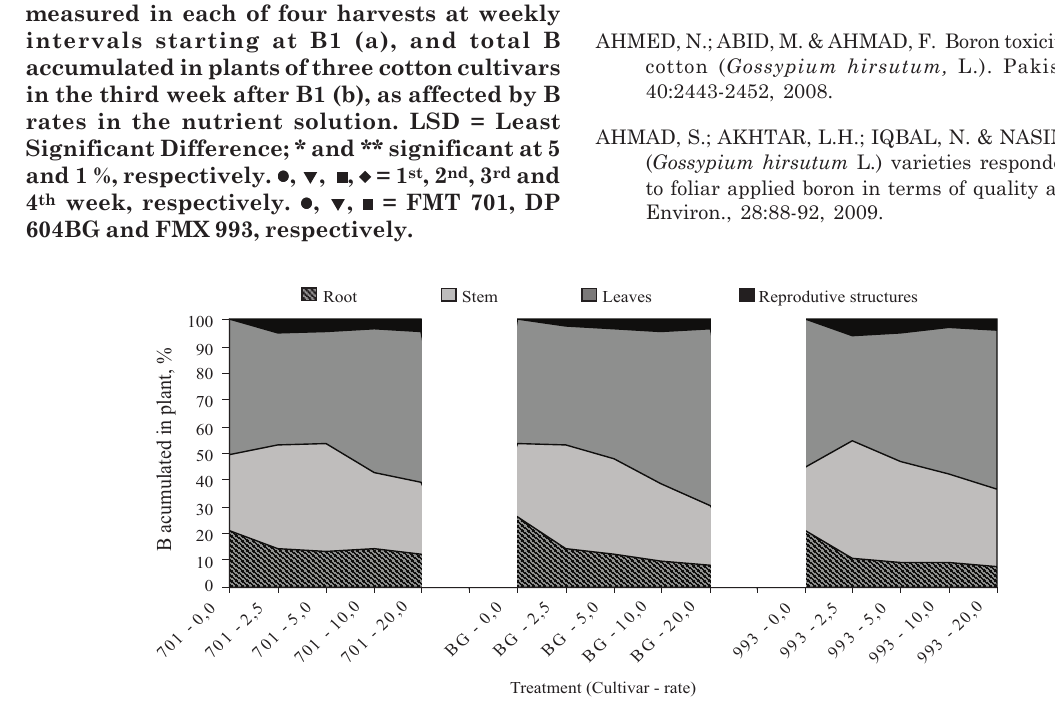
Figure 4. Boron distribution in vegetative and reproductive tissues of cotton cultivars (FMT 701, DP 604 BG, FMX 993), three weeks after B1, as affected by boron doses (0.0, 2.5, 5.0, 10.0, and 20.0 µmol L -1 ) in the nutrient